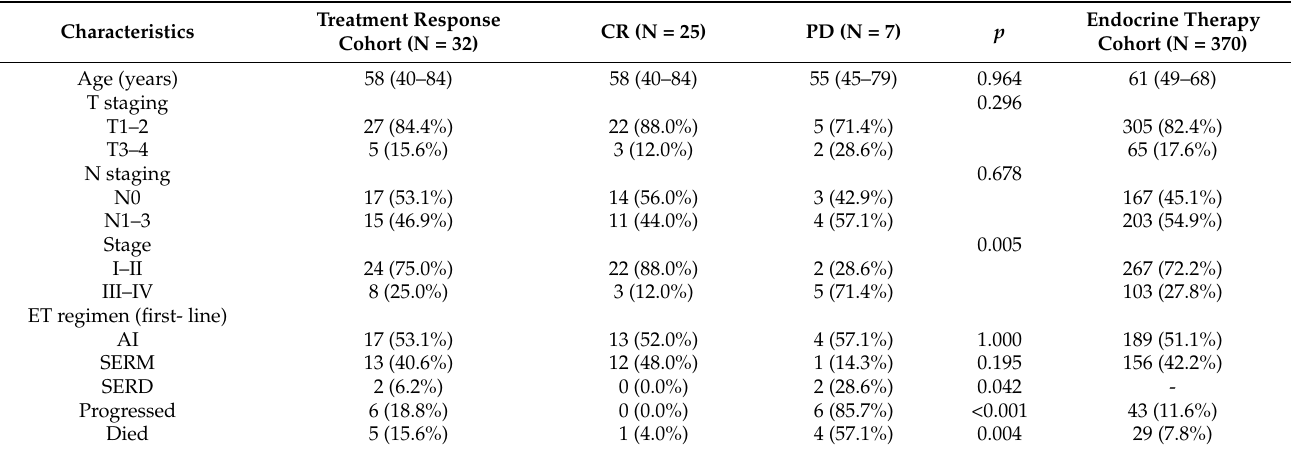
Table 3. Baseline distribution of treatment response and endocrine therapy cohort in RPPA